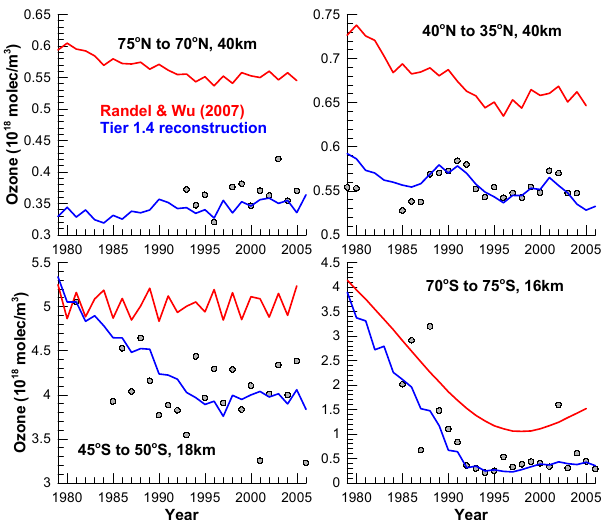
Figure 12. Selected October mean ozone time series from the Tier 0 database (grey dots), from Randel and Wu (2007) (red trace) and from the Tier 1.4 database (blue trace).